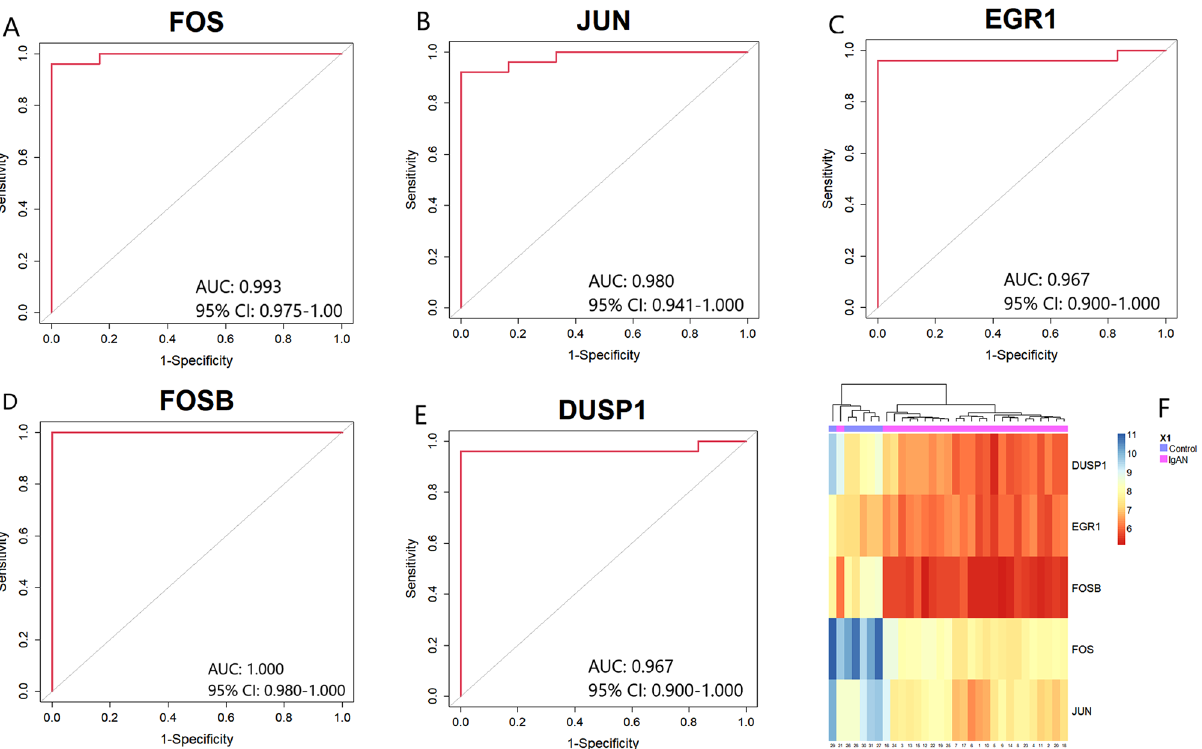
Figure 10. Validation of the five key candidate genes using ROC curves which were generated by pROC package with version 1.18.0 in R 29 (https:// cran.r- proje ct. org/ packa ge= pROC) and heatmap for GSE35487 dataset. ( A ) FOS ( B ) JUN ( C ), EGR1 ( D ) FOSB ( E ) DUSP1 ( F ) Heatmap of the five key candidate genes in renal tissue samples which were generated using “NMF” version 0.24.0 package in R 64 (https:// cran.r- proje ct. org/ packa ge=